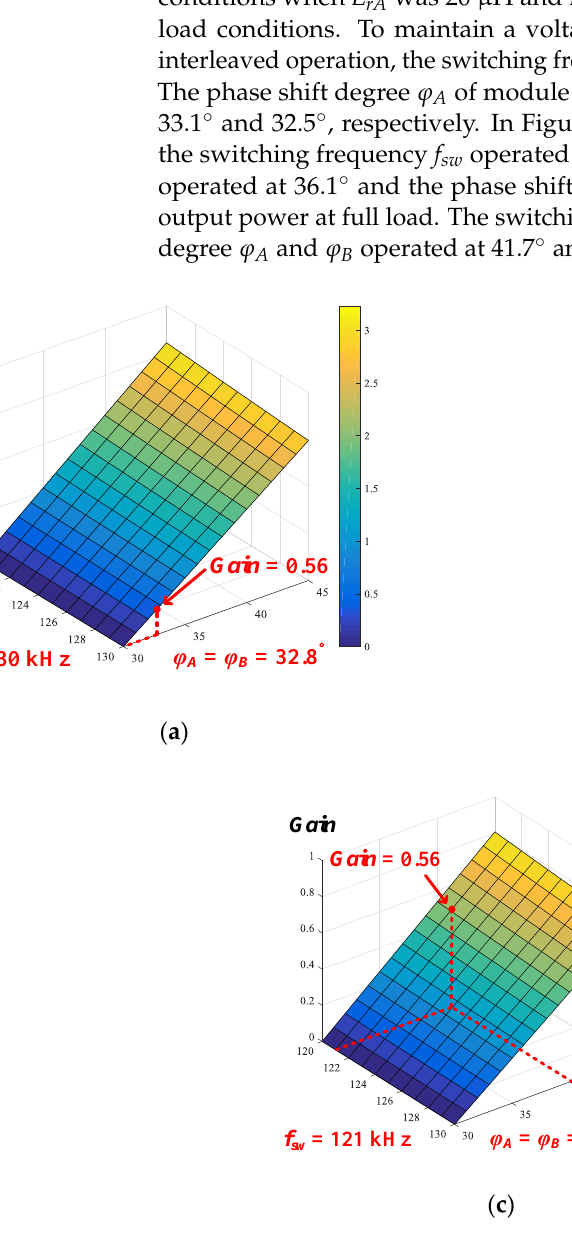
Figure 13. Simulation results of the ideal interleaved three-phase SRC ( L rA = L rB = 18 μH): ( a ) at a 25% output load ( V o = 48 V DC , I o = 6.5 A, R L = 7.38 Ω), ( b ) at a 50% output load ( V o = 48 V DC , I o = 12.5 A, R L = 3.84 Ω), ( c ) at 100% output load ( V o = 48 V DC , I o = 25 A, R L = 1.92 Ω).